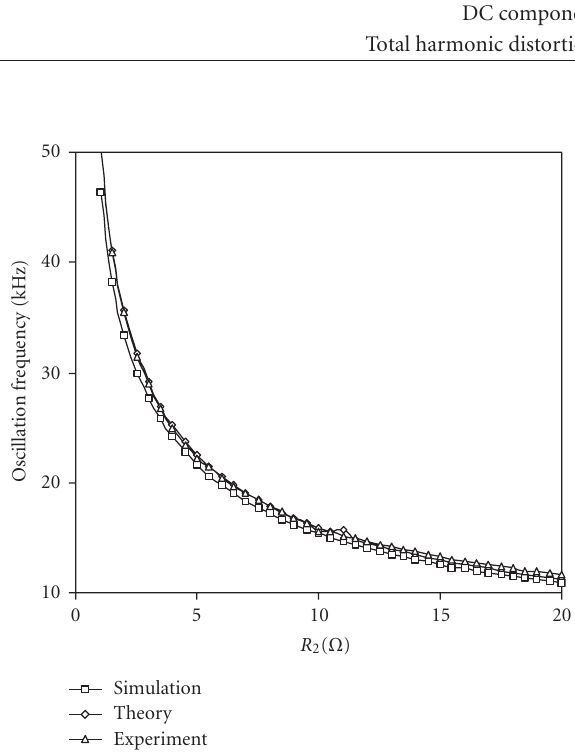
Figure 11: Variation of the oscillation frequency of Figure 4 ob- tained by varying the value of R 2